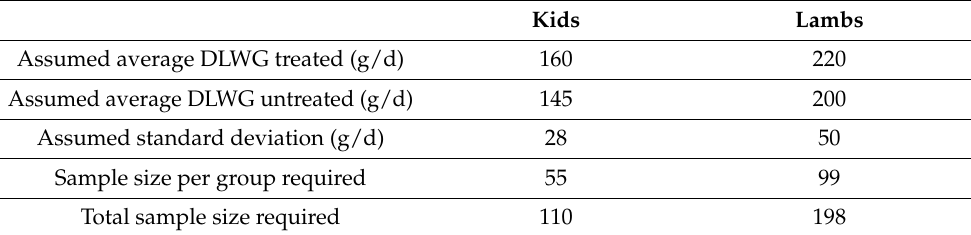
Table 1. Sample size calculation, based on a p -value of 0.05 and a power of 0.8; calculator used: https: